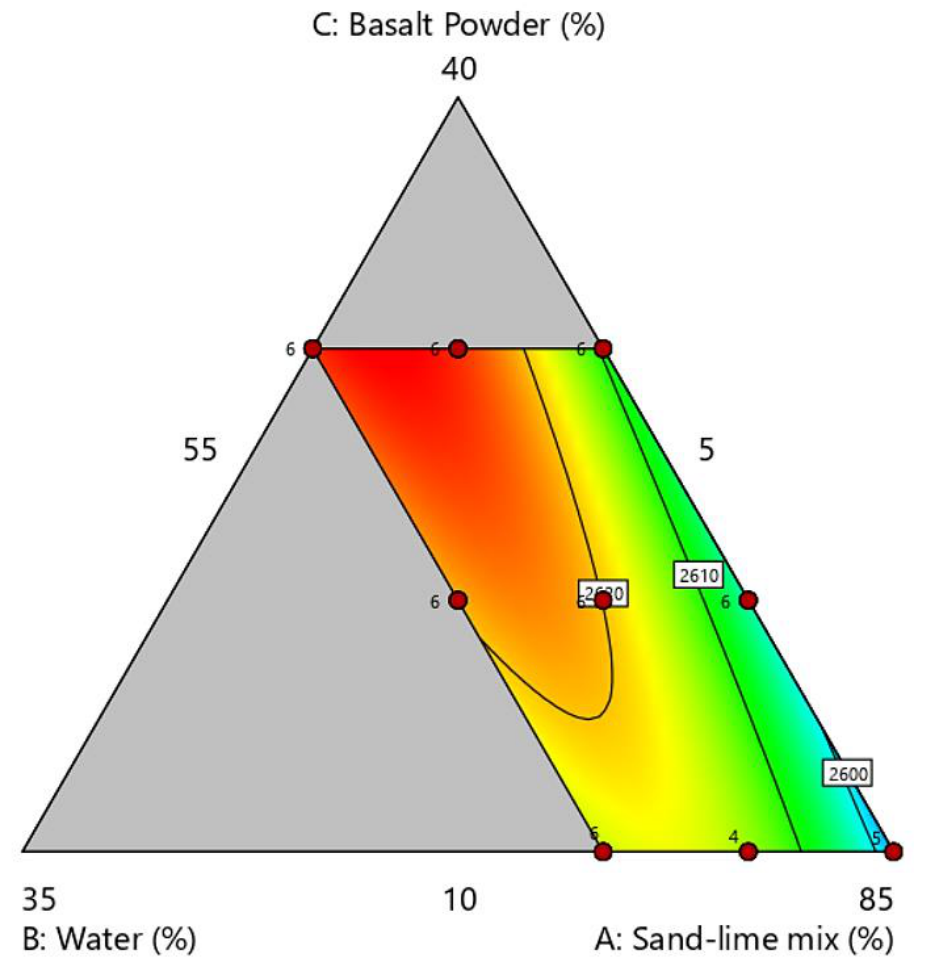
Figure 11. Ternary graph of density.